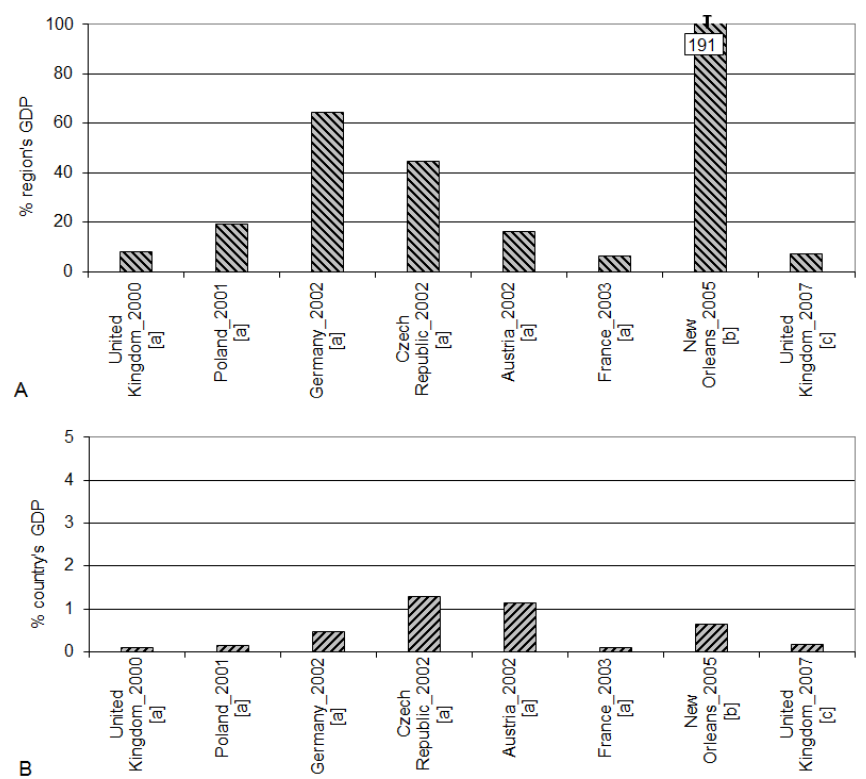
Figure 7. Economic damage in USD for some major flood events as percentage of region’s GDP (a) and country’s GDP (b) . Region’s GDP is assumed equal to GDP per capita × 10 6 . Source of GDP data: United Nations (2013), (a) Barredo (2007), (b) Knabb et al. (2006), (c) EM-DAT (2013).